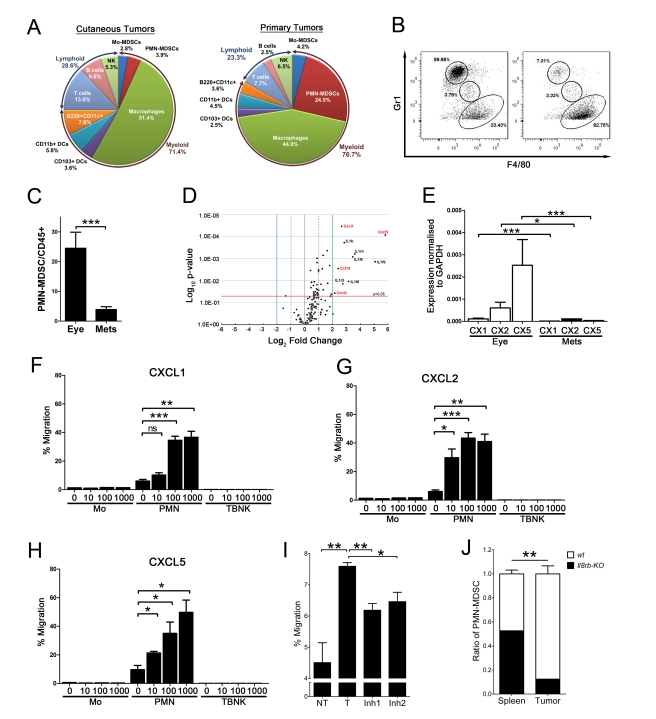
CXCR2 ligands attract PMN-MDSC to the primary tumor.(A) Quantification of the subsets of immune cells infiltrating primary tumors and cutaneous metastases. Data were obtained by flow cytometry from 20 cutaneous and 13 eye tumors. Numbers show the frequencies of each subset among CD45+ cells. Gating strategy for immune cell subsets is illustrated in Figure S1D. (B) Preferential accumulation of PMN-MDSC (Gr1hi F4/80−) in primary tumors. Composition of the primary tumor and a cutaneous cheek tumor from the same mouse. Cells are gated on CD45+CD11c−CD11b+DAPI− tumor cells. (C) Frequency of PMN-MDSC in primary (n = 13) and cutaneous (n = 20) tumors. Bars represent mean ± SEM. ***p value <0.0001, two-tailed unpaired Student’s t test. (D) Repertoire of chemokines and cytokines differentially expressed in primary tumors and metastases. Fold changes represent the log2 ratio of gene expression measured by qRT-PCR in primary tumors (n = 11) and in the metastatic tumors (n = 11). p values were calculated by two-tailed paired Student’s t test. (E) Relative expression of CXCL1 (CX1), CXCL2 (CX2), and CXCL5 (CX5) in 11 primary tumors and 11 metastases measured by qRT-PCR. *p<0.05, ***p<0.001. (F–H) CXCL1 (F), CXCL2 (G), and CXCL5 (H) induce PMN-MDSC chemotaxis in vitro, but have no effect on monocytes or T, B, and NK lymphocytes. x-axis represents the amount of chemokine added in ng/ml. Percentage migration was calculated as (number of migrated cells) ×100/(total cells added per well). Data are from three independent experiments carried out in duplicates. Bars represent mean ± SEM *p<0.05, **p<0.01, ***p<0.001, two-tailed t test. (I) Inhibition of CXCR2 reduces PMN-MDSC migration in vitro. PMN-MDSC were treated 1 h before and during the migration assay with CXCR2 inhibitors—Inh1 (SB265610) and Inh2 (SB225002). Percentage migration was calculated as (number of migrated cells) ×100/(total cells added per well). Data are from two independent experiments carried out in duplicates. Bars represent mean ± SEM *p<0.05, **p<0.01, two-tailed t test. (J) CXCR2 is required for PMN-MDSC accumulation into the primary tumor. Equal numbers of bone marrow cells from Rosa mT/mG reporter mice expressing tdTomato (used as fluorescently tagged wild-type [wt] cells) and Il8rb-KO mice expressing GFP were adoptively transferred into tumor-bearing RETAAD mice. The graph shows the contribution of each genotype to donor-derived PMN-MDSC present in the primary tumor and spleen 18 h after transfer. Data are from four mice. Bars represent mean ± SEM *p<0.05, **p<0.01, two-tailed t test.